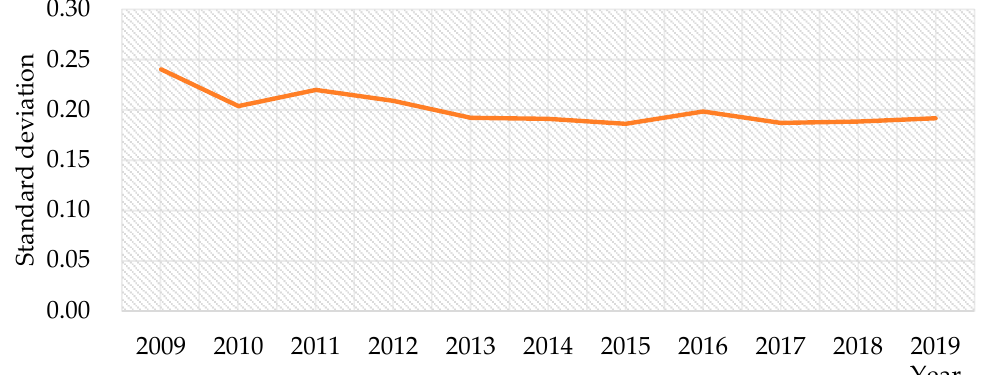
Figure 3. Standard deviation of cultivated land use efficiency in China.